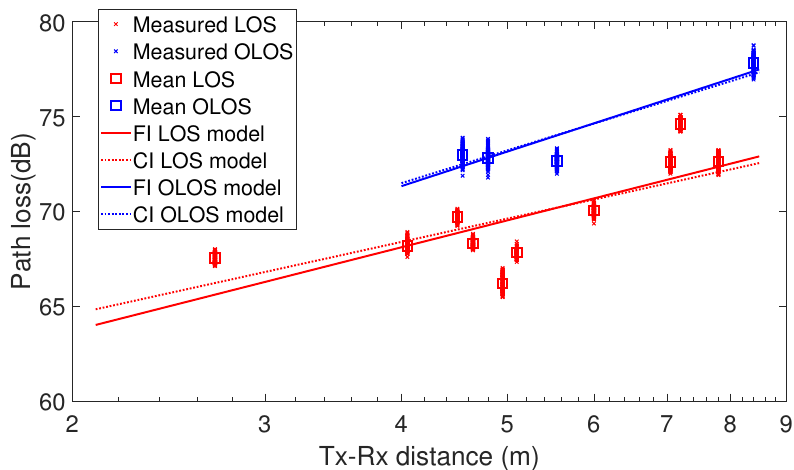
Figure 6. Path loss in terms of the Tx-Rx distance. Measured data, measured mean values, and estimated values from the CI and FI models, in both LOS and OLOS